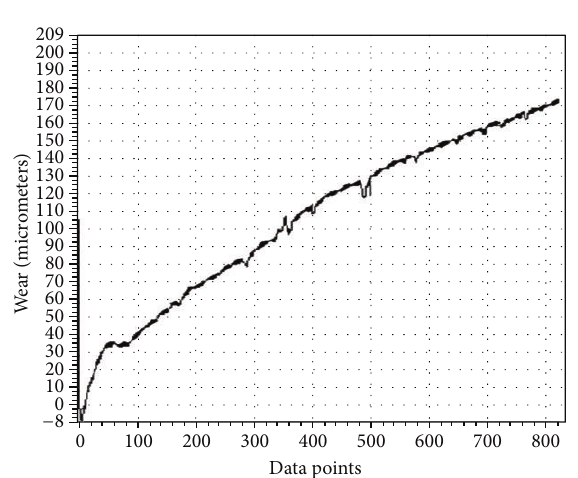
Figure 6: Typical curve of wear of Al-7.5 wt.% Gr composite against steel as a function of sliding time at 1m/s and 49 N.